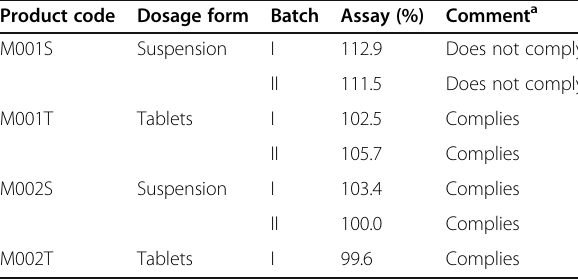
Table 4 Assay results of mebendazole commercial